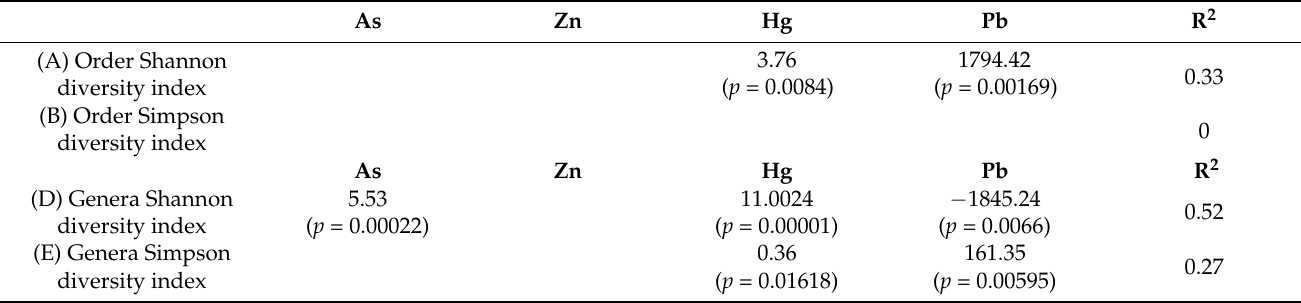
Table 3. Stepwise regression with the estimates of relationship between metals concentrations with the highest loadings from factor analysis (As, Zn, Hg, Pb) regressed against the Shannon diversity index, Simpson diversity index and total number of identified phyla and genera in wetland sites 1–6, including p -values and total R 2 for the regression. As Zn Hg Pb R